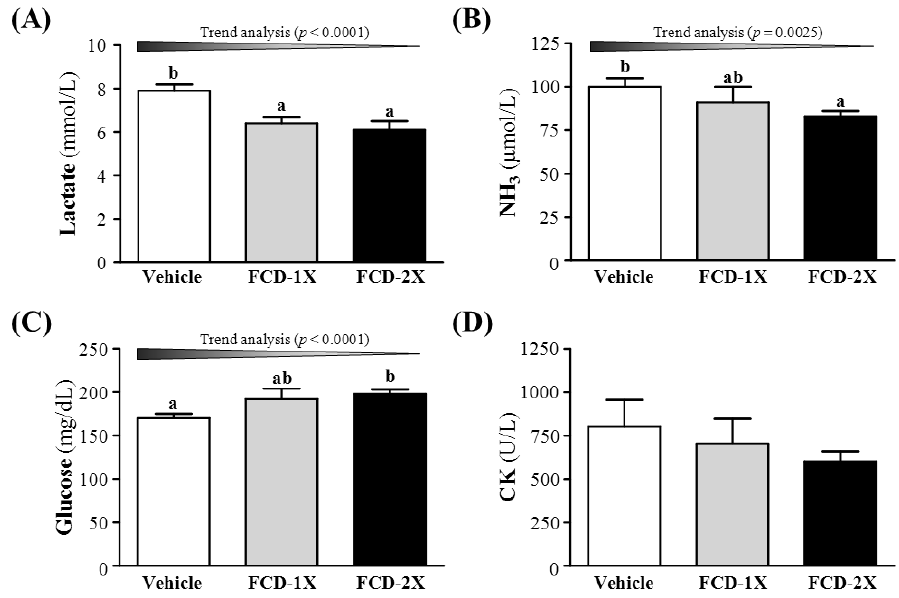
Figure 3. Effects of FCD (Fucoidan) supplementation on serum levels of lactate ( A ); ammonia ( B ); glucose ( C ); and CK ( D ) after an acute exercise challenge. Data represent the mean ± SEM of eight mice in each group. Columns with different letters (a, b) differ significantly, p < 0.05 by a one-way ANOVA. Low-dose (FCD-1X) and high-dose (FCD- 2X) FCD at 310 and 620